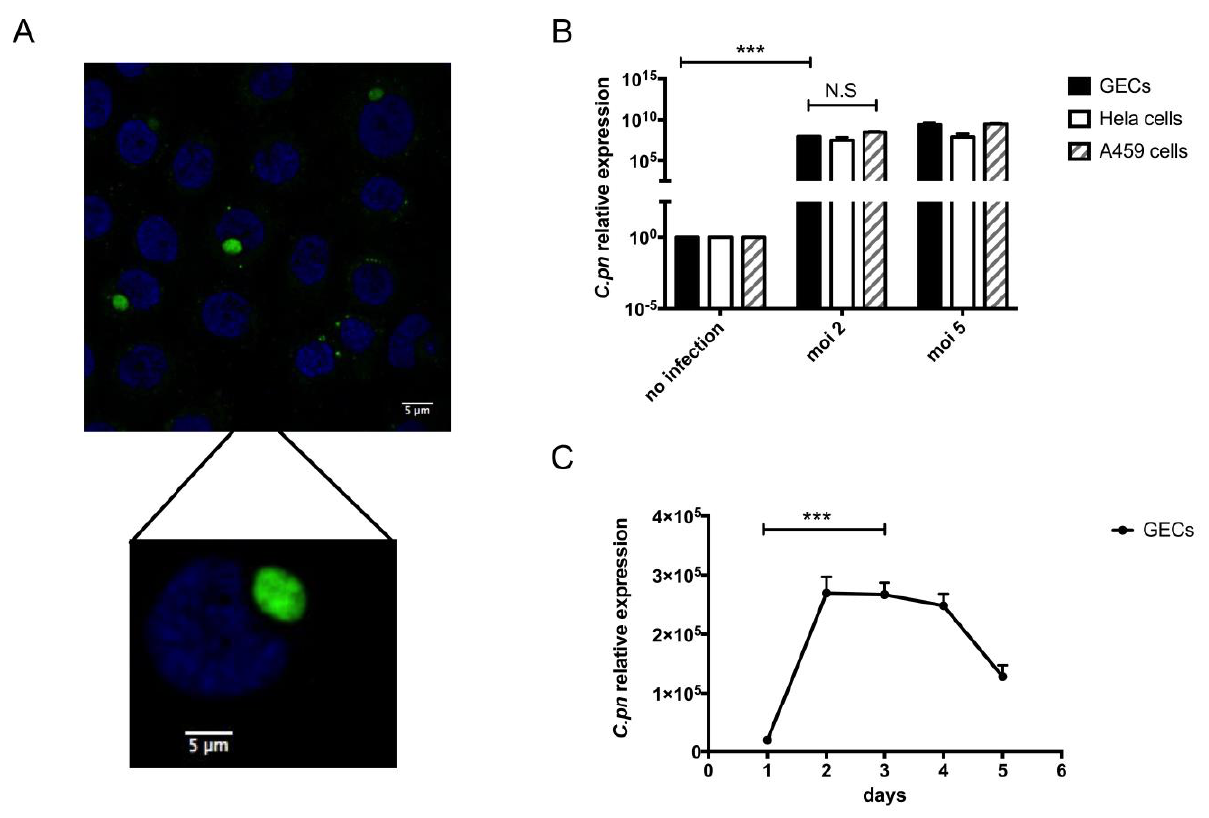
FIGURE 2: C. pneumoniae infects human gingival epithelial cells. (A) . Gingival epithelial cells (GECs), infected four days with C. pneumoniae at MOI of 5, were incubated with a FITC-conjugated mAb against Chlamydia (green) for 15 minutes, and the nuclei were counterstained with Hoechst (blue). (B) qPCR of hGECs, HeLa cells, and A549 cells infected with C. pneumoniae for two days at MOI of 0, 2 and 5. qPCR assays were performed in triplicate, n = 4 independent experiments. Error bars represent ± SD; 2-sided, paired Student’s t test, *** P < 0.001. (C) GECs were infected with C. pneumoniae at MOI of 5 and infected samples were collected 1, 2, 3, 4 and 5 days post-infection for qPCR analysis. Assays were performed in triplicates, n = 5 independent experiments. Error bars represent ± SD; 2- sided, paired Student’s t test, *** P <